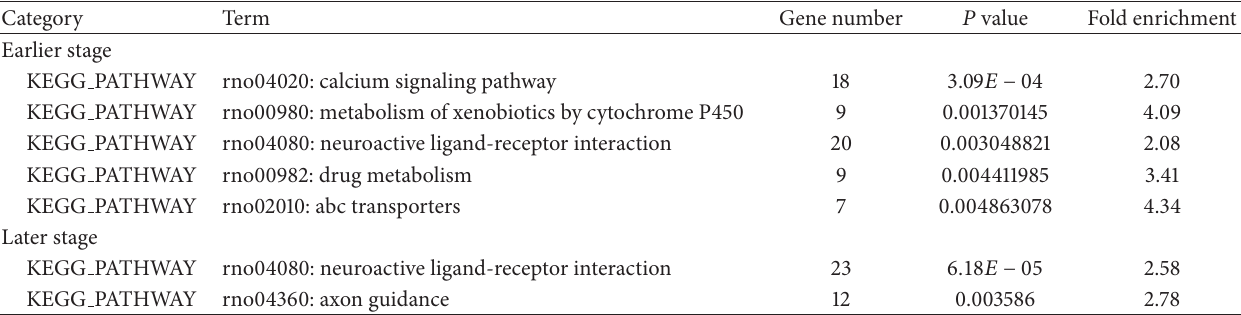
Table 4: KEGG pathway analyses of DEGs in earlier stage (upper) and later stage (lower).